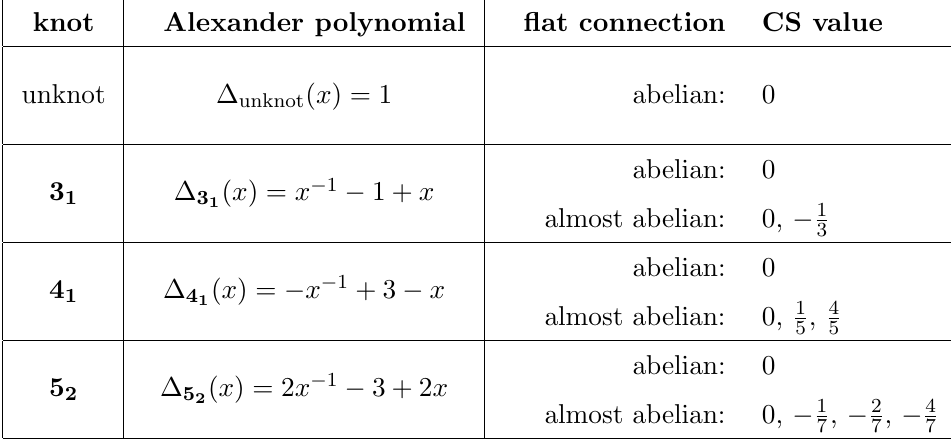
Table 2 . Alexander polynomials and (cid:13)at connections for 0-surgeries on some simple knots. The 0- surgeries on knots 3 1 , 4 1 , and 5 2 have 2, 3, and 4 non-abelian (cid:13)at connections, represented here by their Chern-Simons values, that are \almost abelian" in the sense brie(cid:13)y mentioned below (2.27) and explained more fully in section 3. In addition, in all three cases, there are 2 complex (cid:13)at connections at the singularities of the abelian